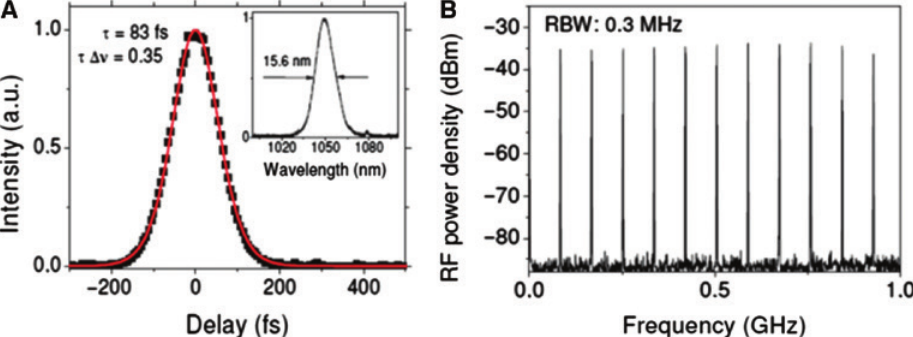
Figure 12: CNT SA mode-locked Yb:KYW/KYW laser. (A) ACF with sech2 pulse shape fiting and the corresponding spectrum with a bandwidth of 15.6 nm (inset) and (B) the corresponding RF spectra in a frequency span of 1 GHz with a resolution bandwidth (RBW) of 0.3 MHz. Schmidt et al. [50] © 2009 Optical Society of America.